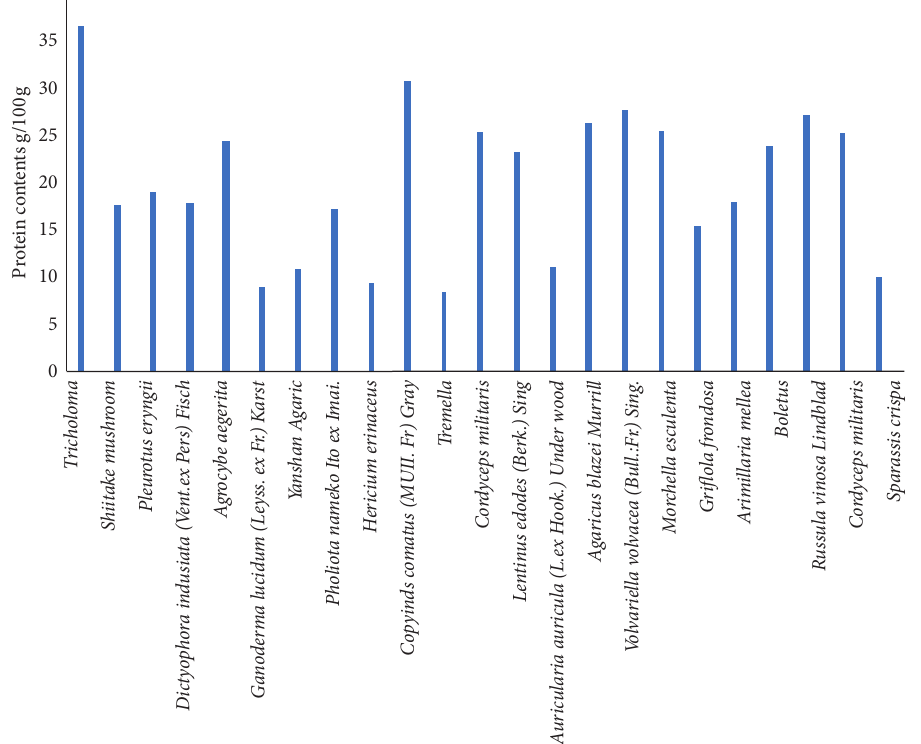
Figure 3: Protein contents of 23 kinds of edible